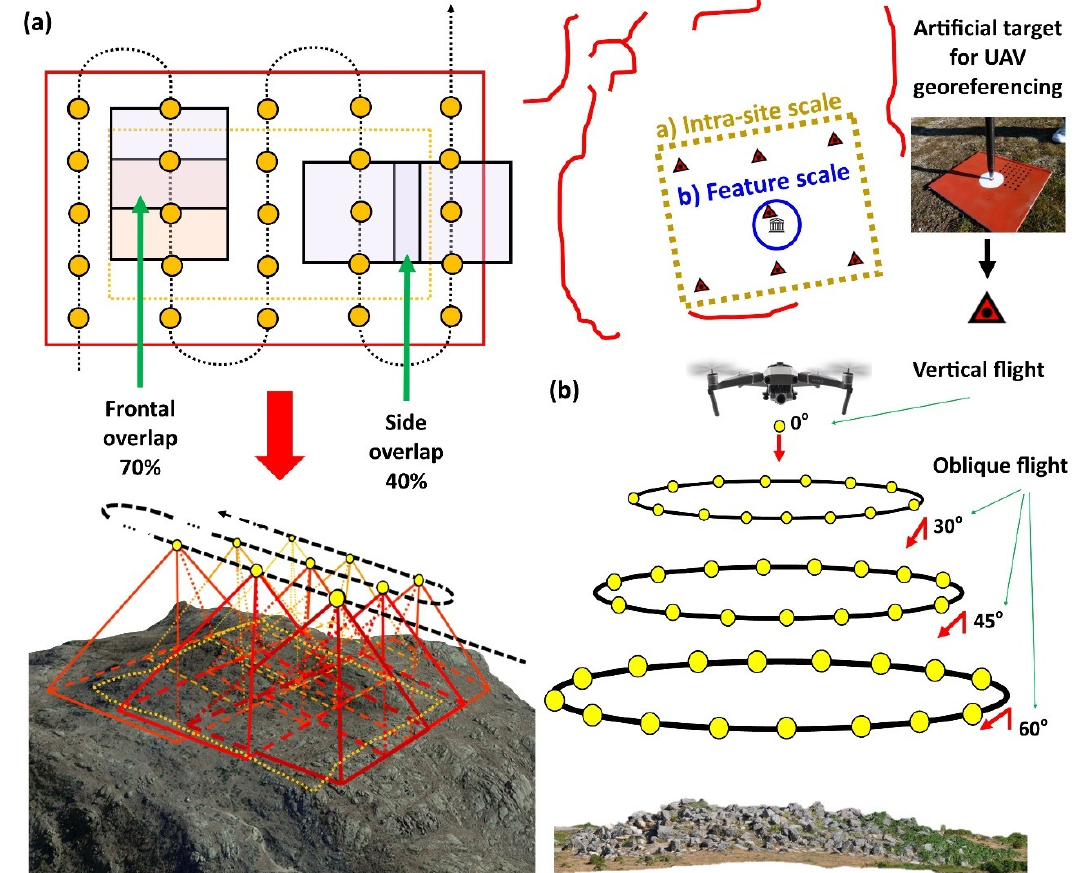
Figure 3. ( a ). Flight plan following a parallel photographic shooting protocol for the elaboration of the cartography for the ROI. ( b ). Flight plan following an oblique/convergent photographic shooting protocol for the documentation of “El Torreón” ruins.